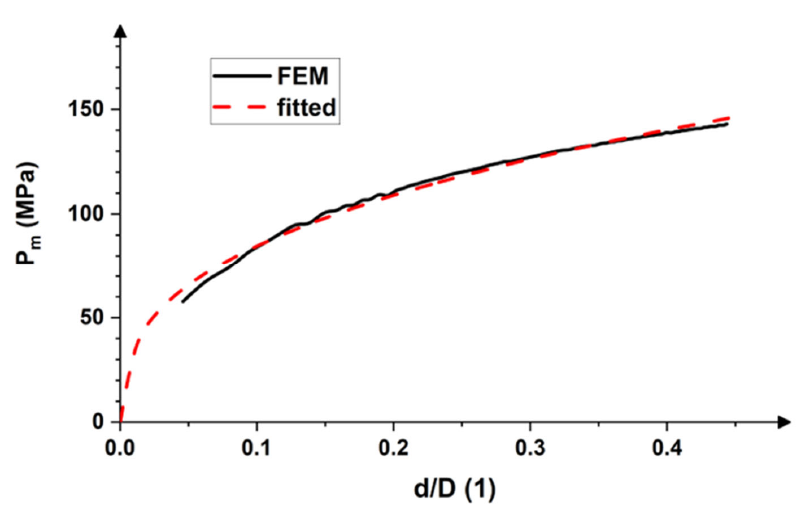
Figure 8. FEM-computed and analytically fitted curves (Equations (20) and (21)) of surface pressure over indentation per indenter size ratio d/D .